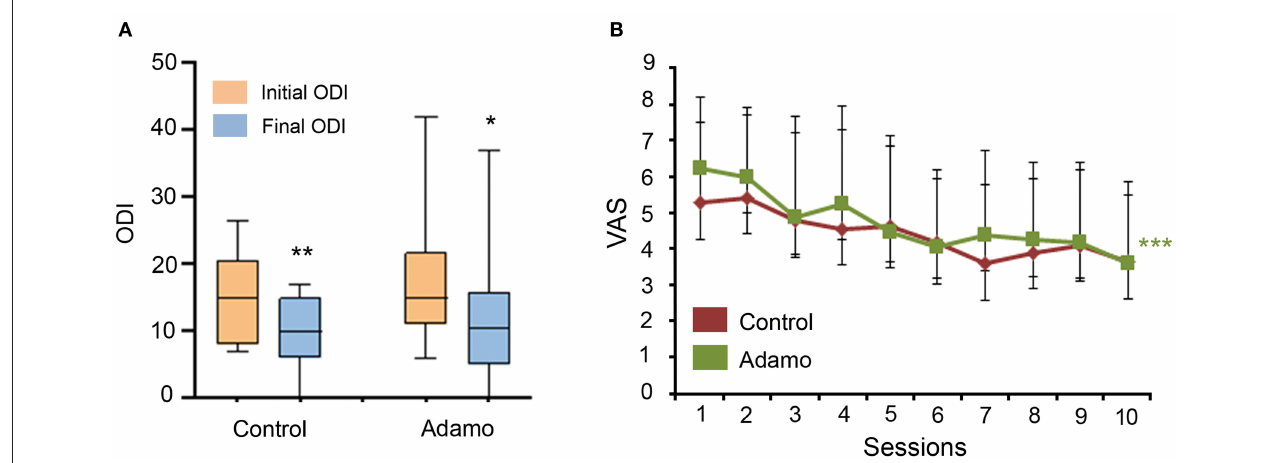
FIGURE 3 | Comparison of the ODI (A) and VAS (B) scales before and after the treatment in both arms of the study. ODI values are expressed as box plots, which represent the interquartile range with the median as a horizontal line. Whiskers encompass the maximum and minimum values of the population. * p < 0.05, ** p < 0.01, compared to initial ODI. VAS values are represented as the median (Q1–Q3) for each time point. *** p < 0.001, compared to initial